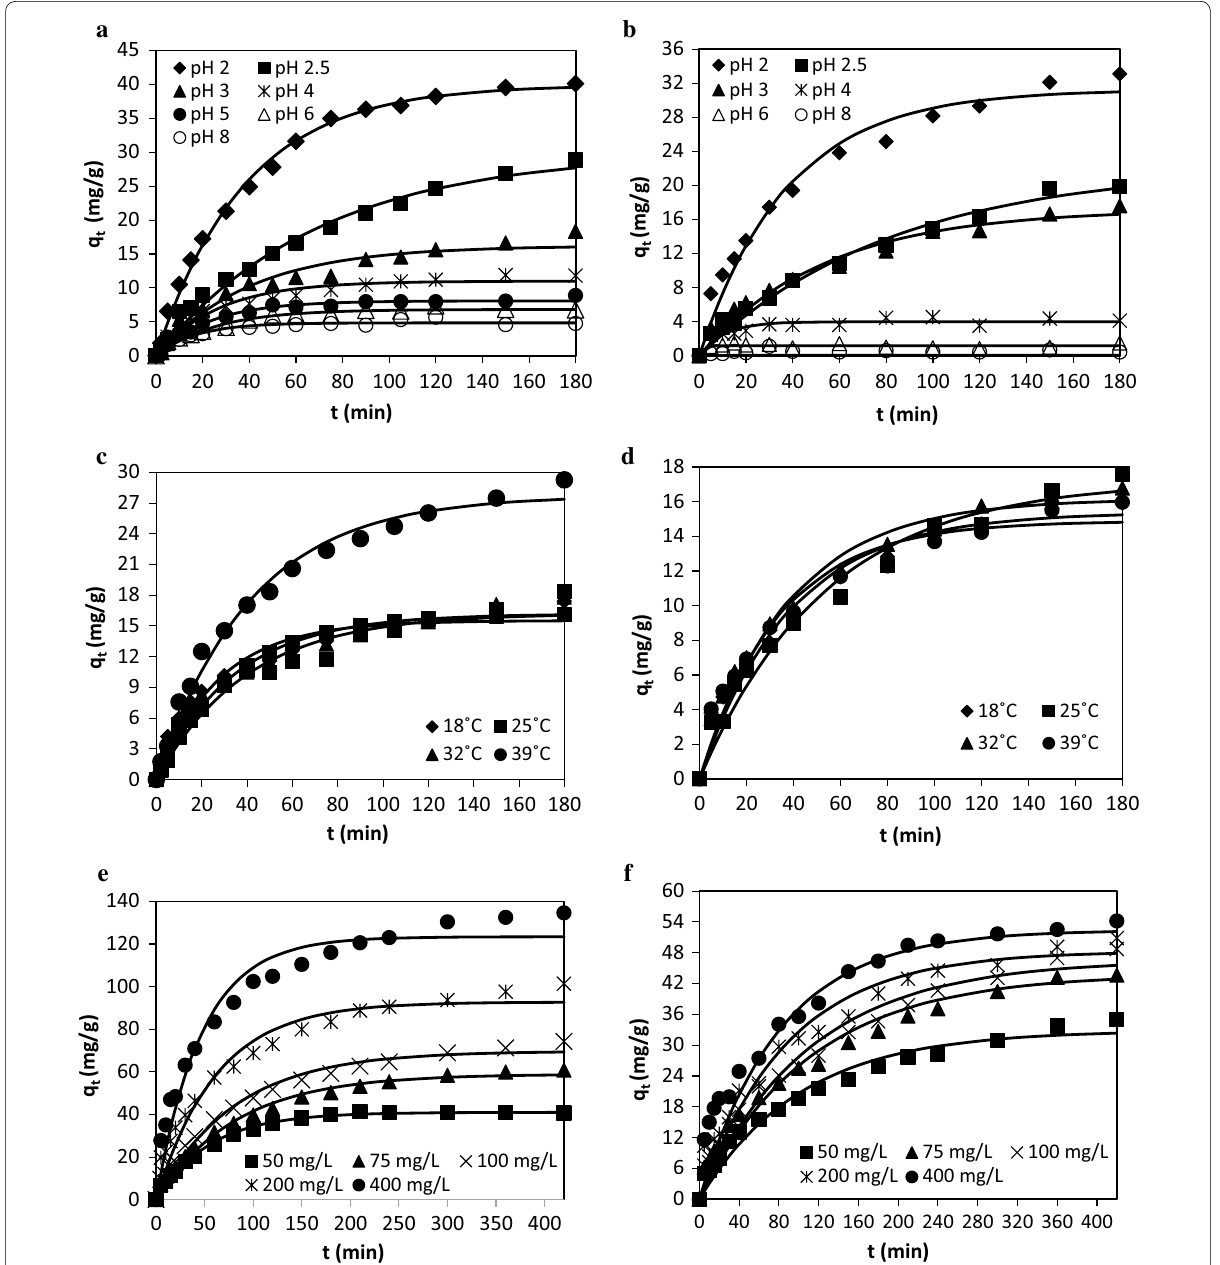
Fig. 2 Kinetic data (points represent experimental data, solid lines represent pseudo-first-order model data) of removal of Remazol Navy: at different pHs by a living and b inactivated grains (C dye 100 mg/L, C Kefir 2.4 g/L, T 25 °C); at different temperatures by c living and d inactivated = = = granis (C dye 100 mg/L, C Kefir 2.4 g/L, pH 3); at different initial dye concentrations by e living and f inactivated grains (C Kefir = = = pH =